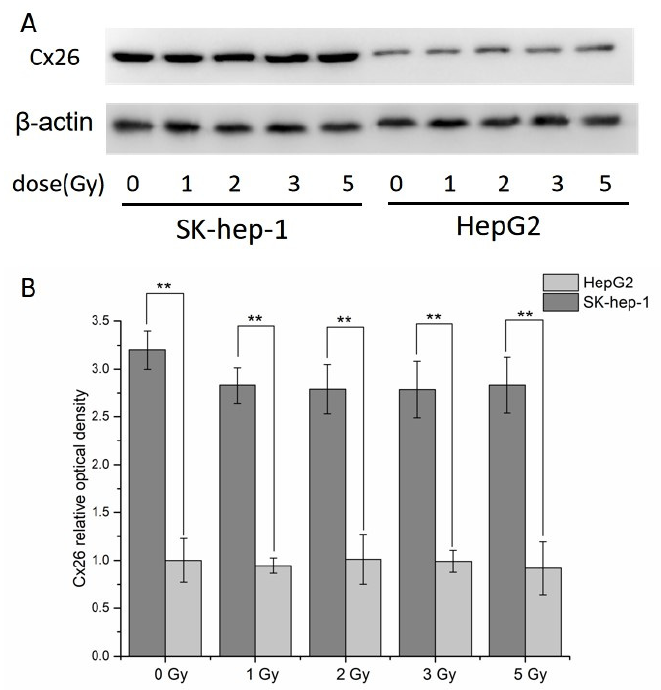
Figure 2. Cx26 expression levels in HepG2 and SK-hep-1 cells 6 h after X-ray irradiation. ( A ) The typical image of Cx26 expression in HepG2 and SK-hep-1 cells 6 h after X-ray irradiation. ( B ) The relative optical density analysis result of Cx26 in HepG2 and SK-hep-1 cells 6 h after X-ray irradiation. ** p < 0.01 compared between the two cells.